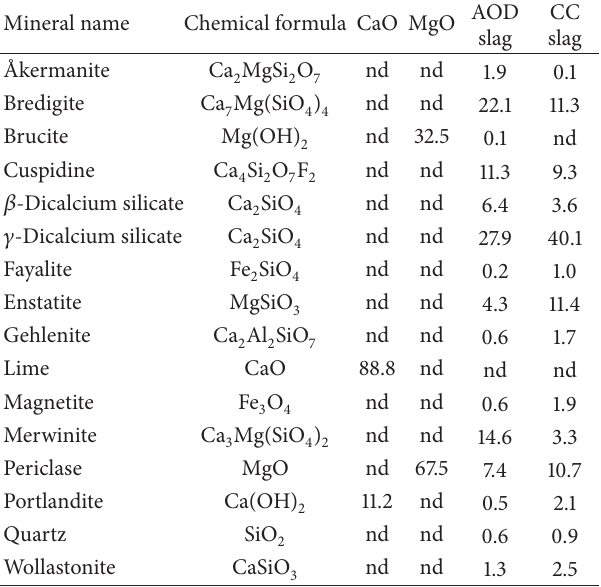
Table 2: Mineral composition of alkaline materials determined by QXRD (wt% of crystalline